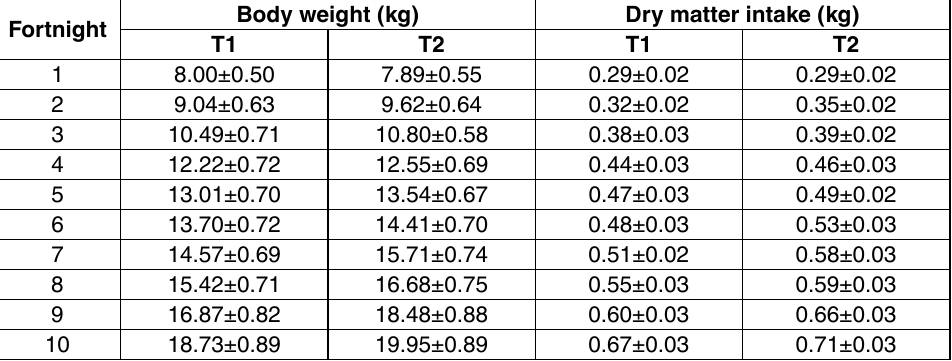
table 4 . Haematobiochemical profiles of Malabari kids fed with M. oleifera leaves.